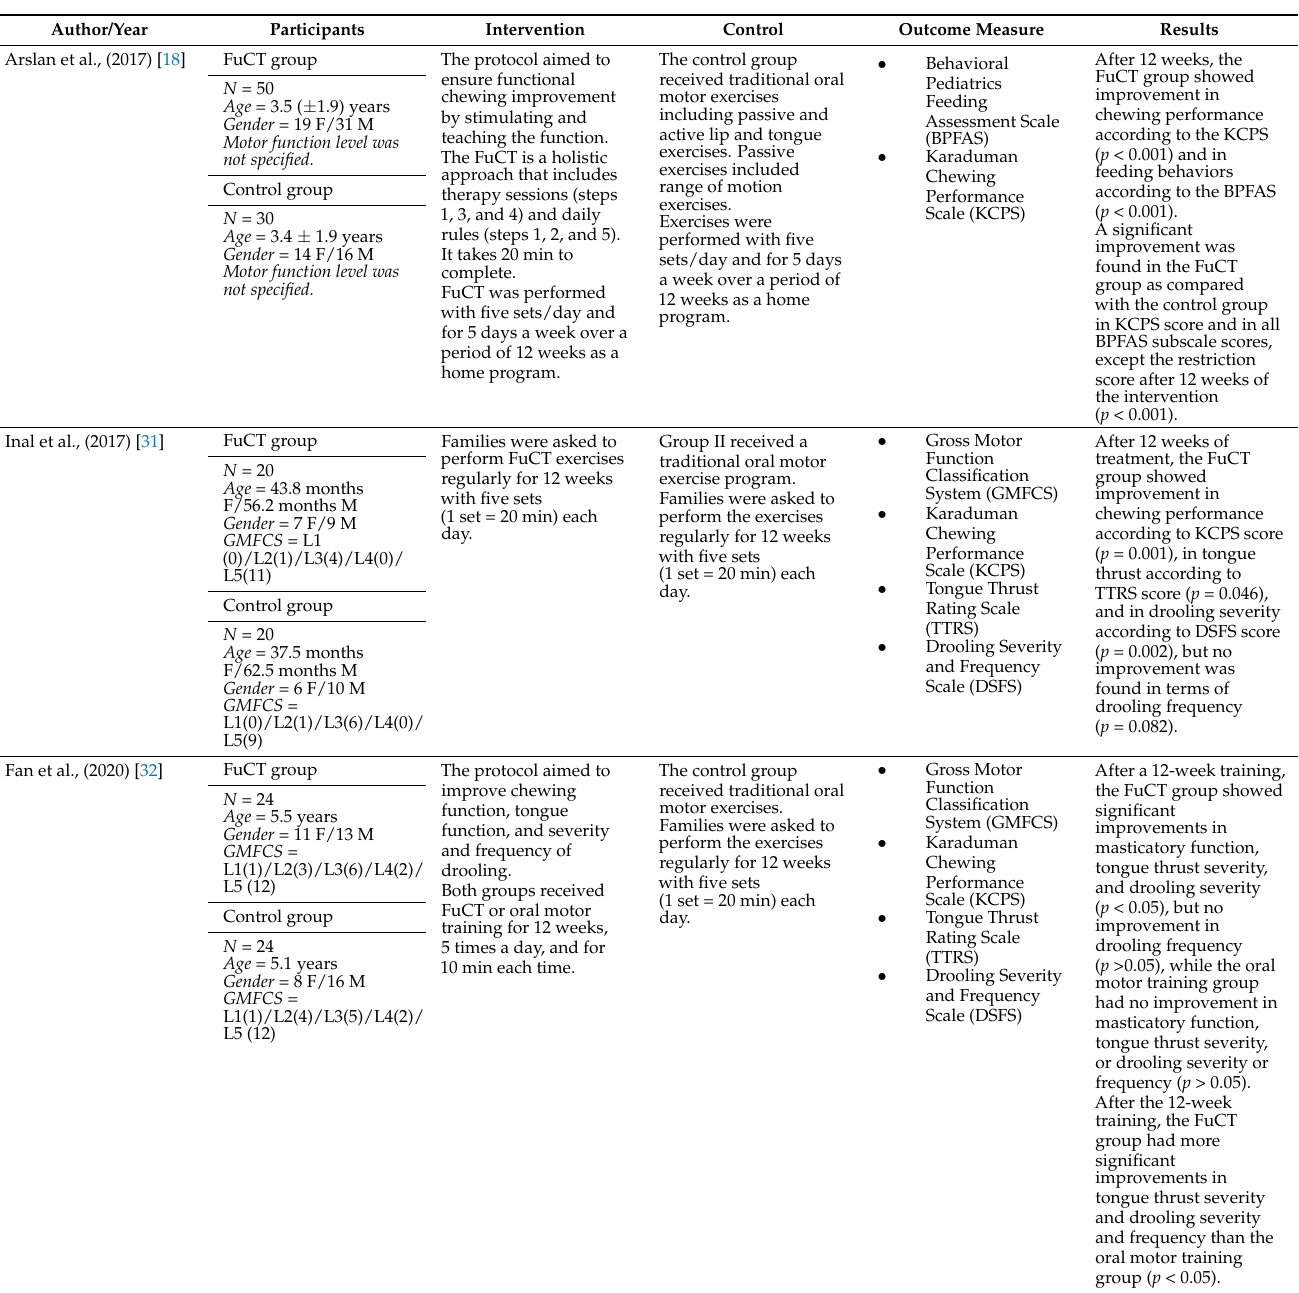
Table 2. Study characteristics and main